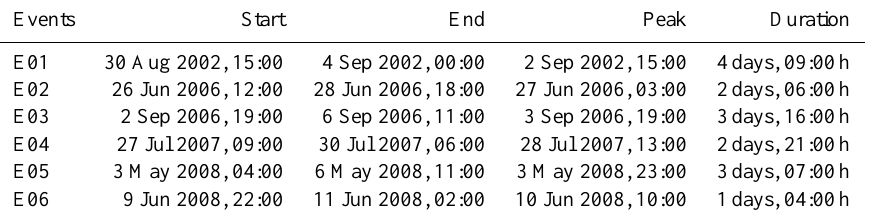
Table 2. Extreme wave events: the start time gives the time at which the waves of these events started to appear in the computational domain. The end time indicates when the waves leave the domain. The peak time gives the most energetic moment in each event, and the duration is the time between the start and the end.